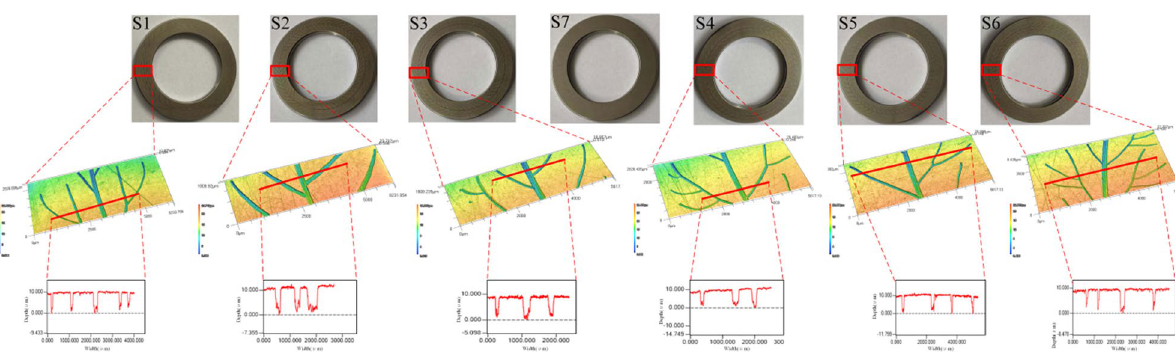
Figure 3. Optical images, 3D topographies and profile curves of vein-bionic textured bearings